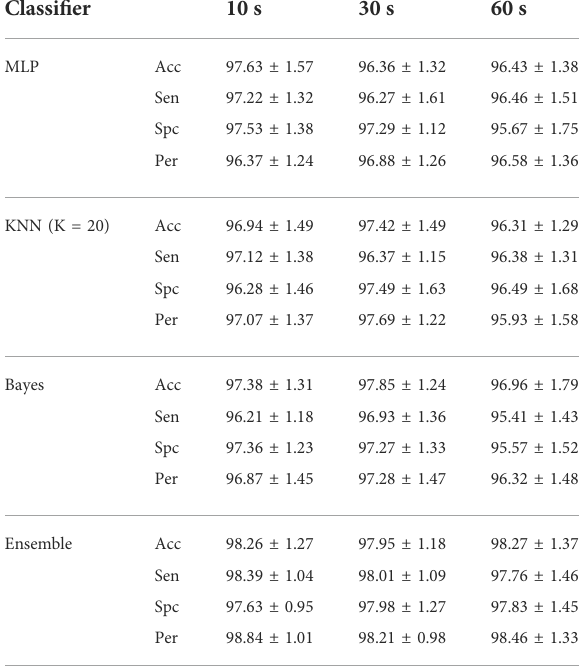
TABLE 6 Classi fi cation performance in the 2-class scenario using the most signi fi cant features from Table 5 for the normalized EEG components over all samples from simulated, semi-simulated, and real